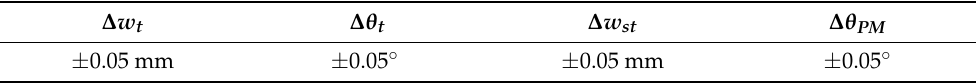
Table 9. Manufacturing and assembling